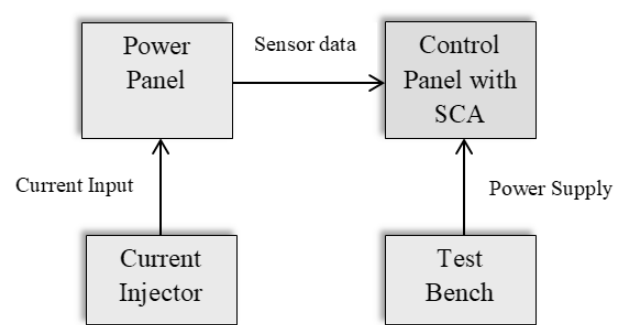
Figure 4: Test setup. It consists of four main parts namely power panel, current injector, control panel with SCA and test bench.